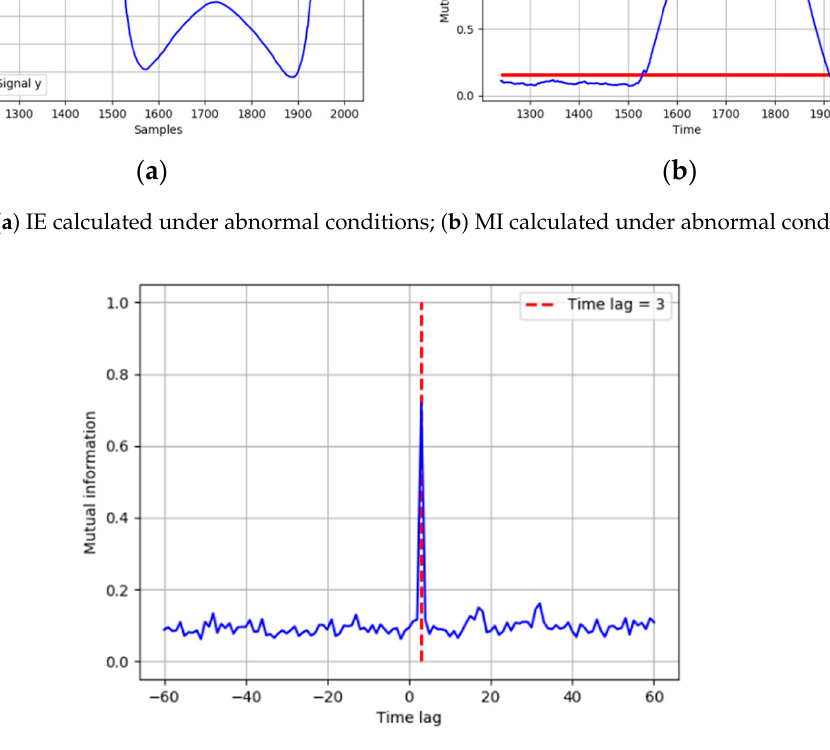
Figure 8. MI with different time lags.